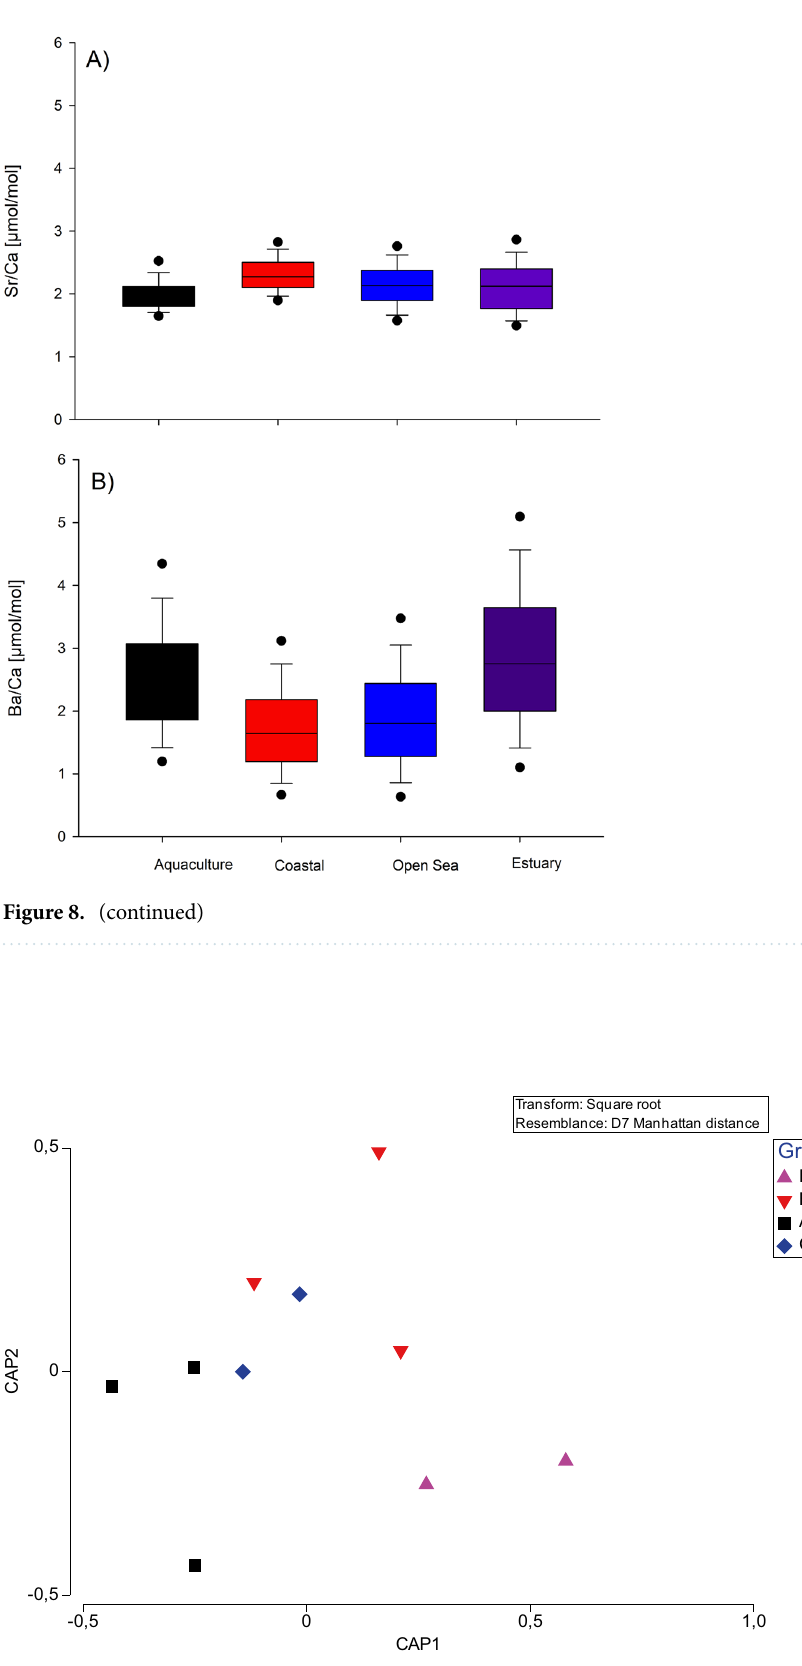
Figure 9. Canonical variate plot (CAP) for Sr/Ca element chemistry of the otoliths of Sparus aurata grouped specimens for A—aquaculture, B—coastal area, C—open sea and